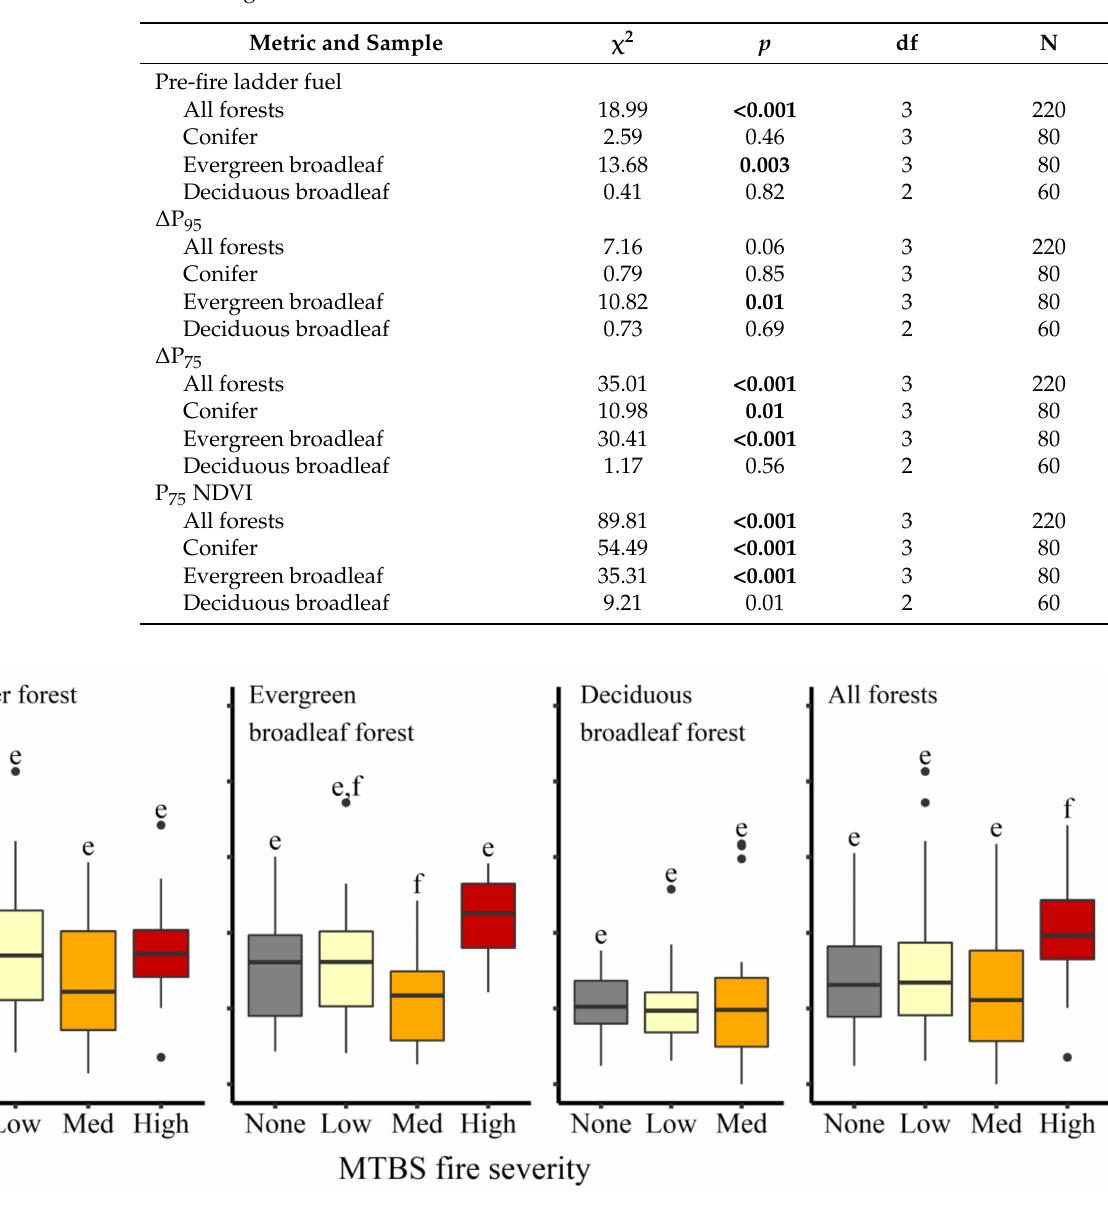
Table 4. Kruskal–Wallis one-way analysis of variance results for 2017 Tubbs fire burn severity impact metrics. Significance at the 95% level denoted in bold.